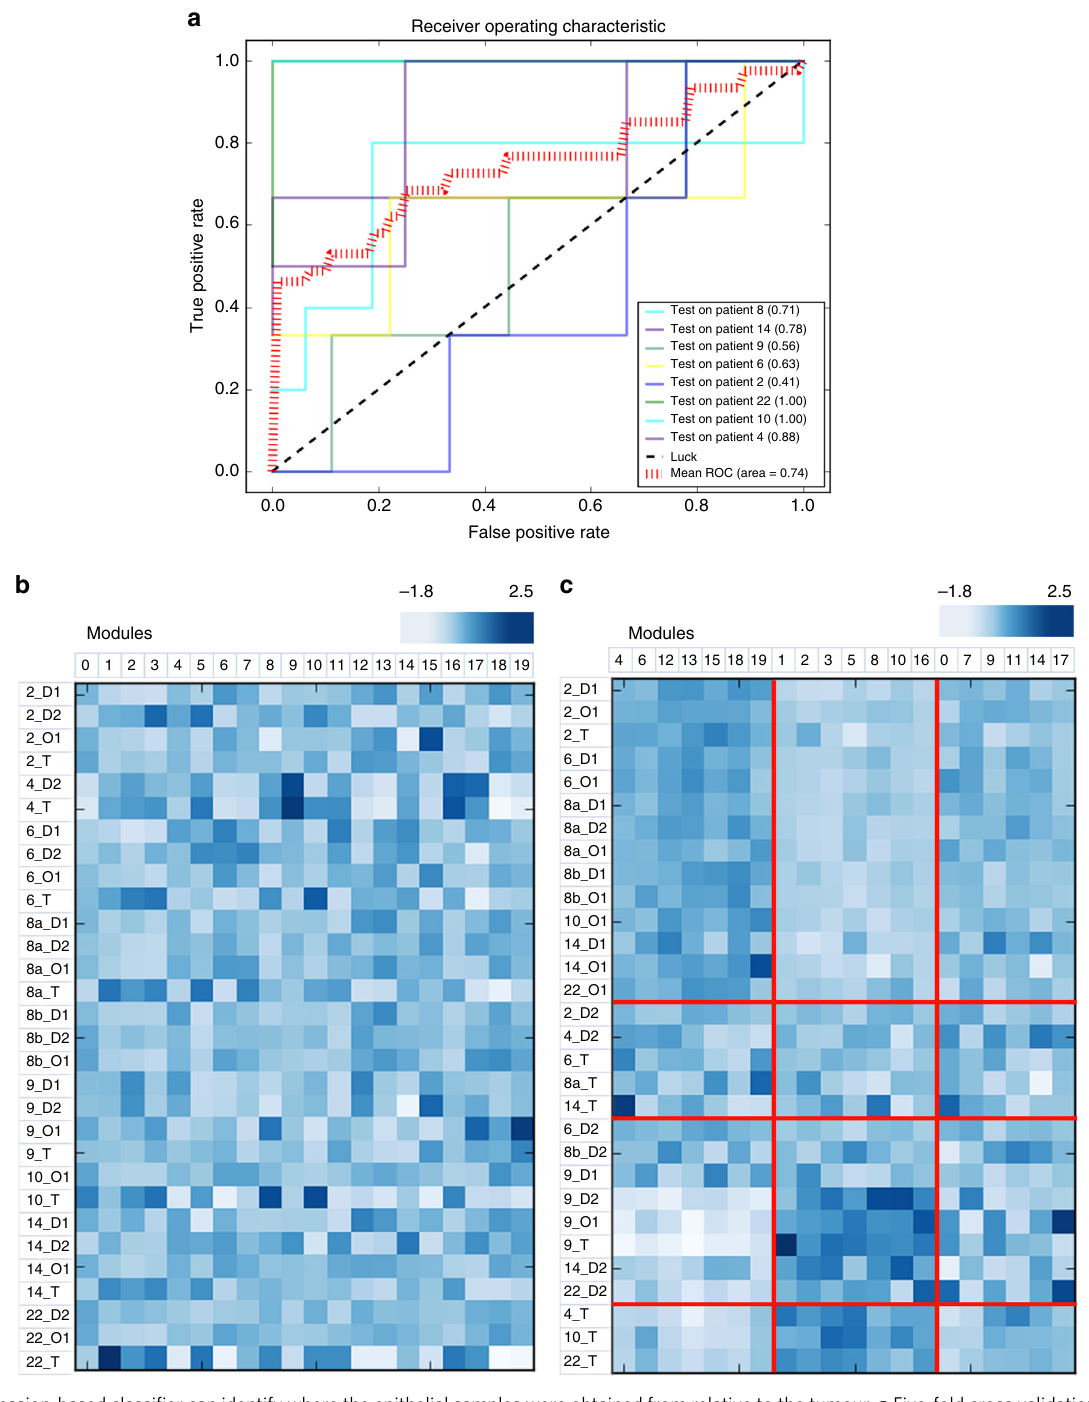
Fig. 2 Expression-based classi fi er can identify where the epithelial samples were obtained from relative to the tumour. a Five-fold cross validation, depicting the receiver-operating curve (ROC) response of using each patient as a test; mean micro-average AUC = 0.74. b Original unclustered data set: columns depicted modules of genes identi fi ed through a hierarchical-clustering based gene agglomeration approach and rows corresponding to each epithelial sample. c Spectral co-clustering reveals biclusters of samples and modules that are both downregulated (modules 4, 6, 12, 13, 15, 18 and 19) and upregulated (modules 1, 2, 3, 5, 8, 10 and 16) in tumours and adjacent-to-tumour epithelium. All genes in these modules were selected a priori as univariately informative of the proximity-to-tumour label (top 30% of all genes; see Text). Clustering was done to further reveal structure within these univariately informative genes. Modules that are downregulated are negatively correlated with proximity to tumour (Table 1), and similarly, modules that are upregulated are positively correlated with proximity to tumour (Table 1). The sampling clustering has a Rand index of 0.21 with the distance-based grouping of the samples; the bottom three sample clusters are largely composed of tumour (T) and adjacent-to-tumour epithelial samples (D2). In contrast, the top cluster is composed largely of distant and contralateral duct epithelial samples (D1 and O1,